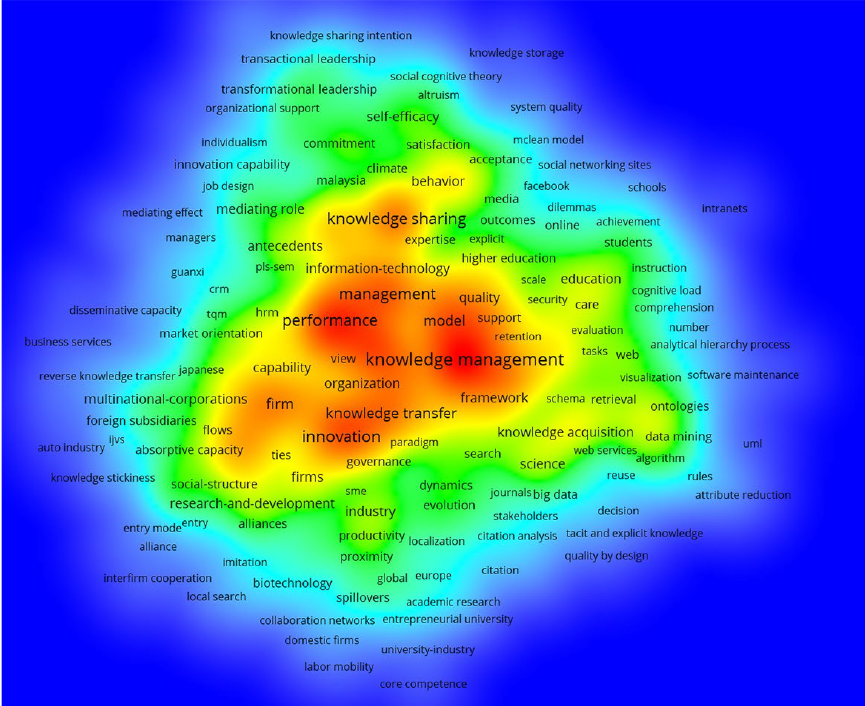
Figure 3. Co-word analysis of keywords: heat